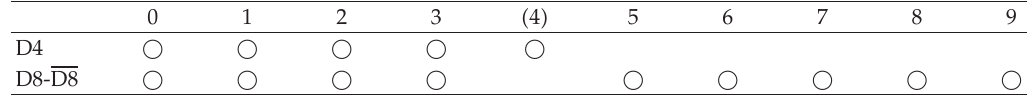
Table 4: The D4/D8/D8 brane intersection in 9 (cid:8) 1-dimensional flat